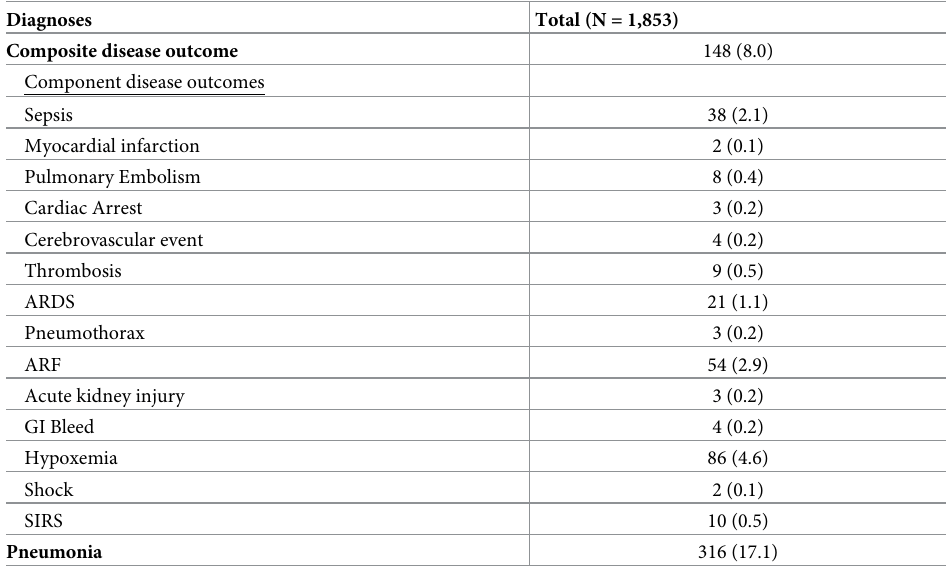
Values are in number (%) for categorical variables and median (IQR) for continuous variables. ARDS = Acute Respiratory Distress Syndrome, ARF = Acute Respiratory Failure, GI = Gastrointestinal, SIRS = Systemic inflammatory response syndrome. Disease classification based on ICD-10 (CM) codes abstracted from